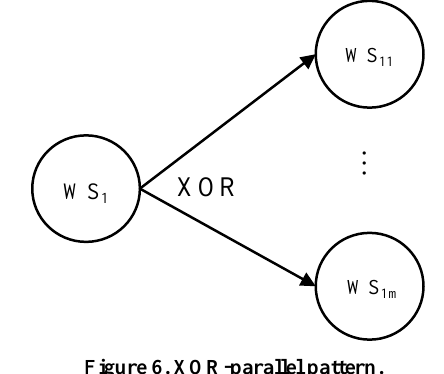
Figure 6. XOR-parallel pattern.